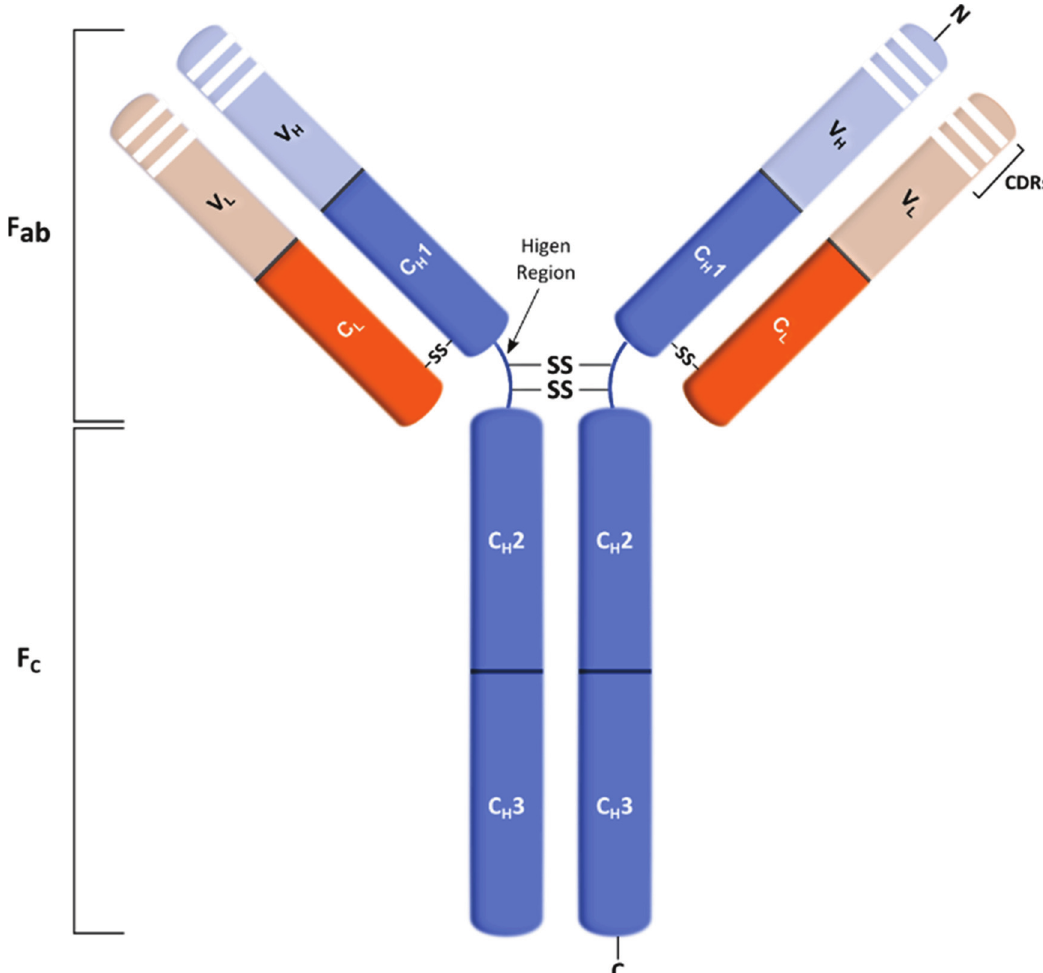
Figure 3. Schematic representation of an immunoglobulin G (IgG) mAb structure. The IgG molecule is composed by constant (C) and variable (V) domains for each light (L) or heavy (H) chain. The heavy chain comprises three constant domains (C H ) and one variable (V H ), and the light chain contains one constant (C L ) and one variable (V L ) domain. This molecule can be divided into F c and F ab regions in which the latter includes the variable regions, called complementarity-determining regions